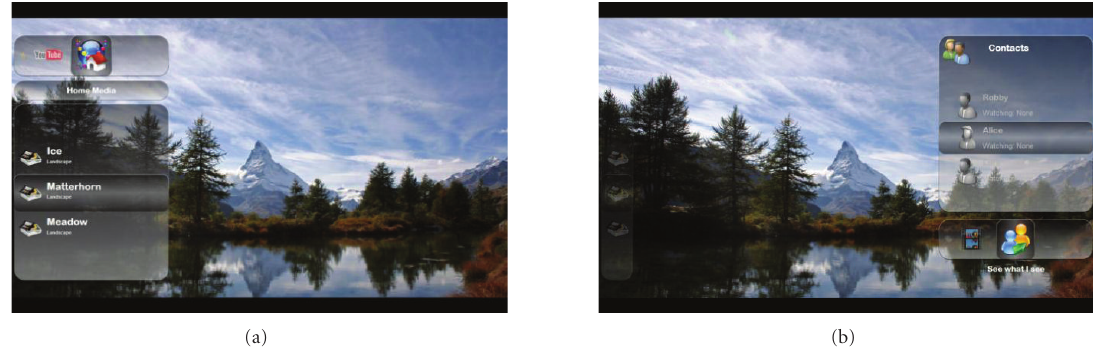
Figure 4: Surfing the home media content (a) and pushing the home media content to my contacts